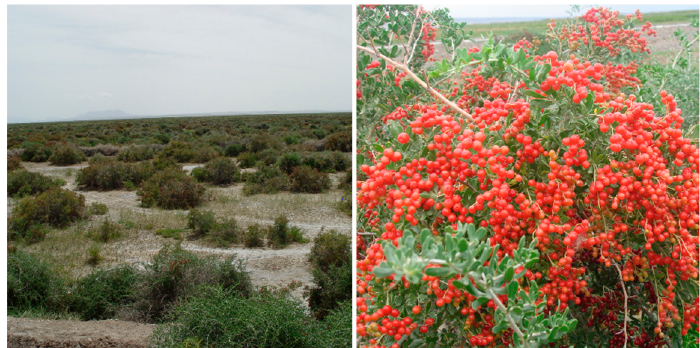
Figure 1. Living environment and fruits of Nitraria tangutorum Bobr.